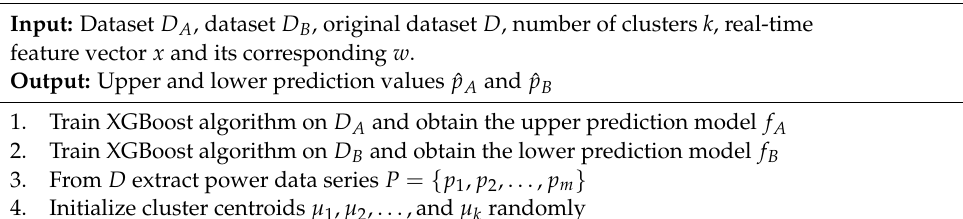
Algorithm 1 : Non-continuous Regression